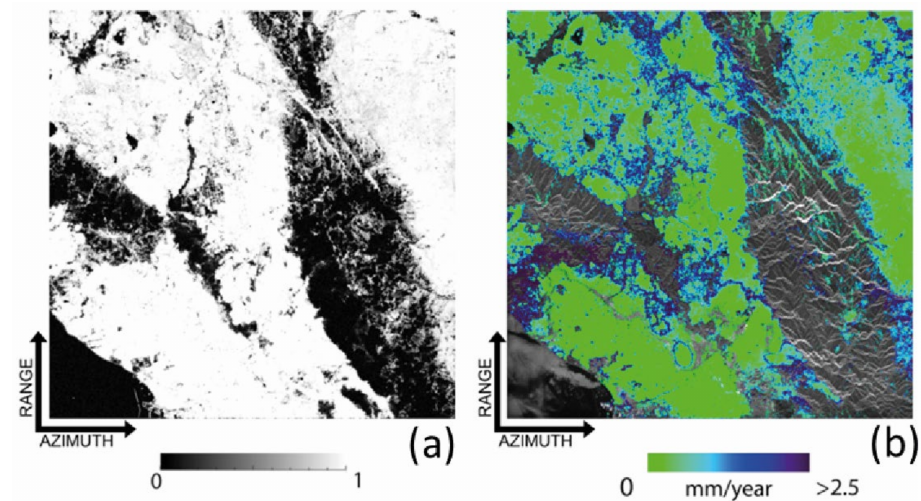
Figure 13. ( a ) Temporal coherence map of South California area (test-site case with the maximum perpendicular baseline of 200 m), ( b ) map of the absolute error (upper bound) of the ground mean displacement rate after SBAS inversion; the map does not take into account the effects of APS and the residual topography of the area.